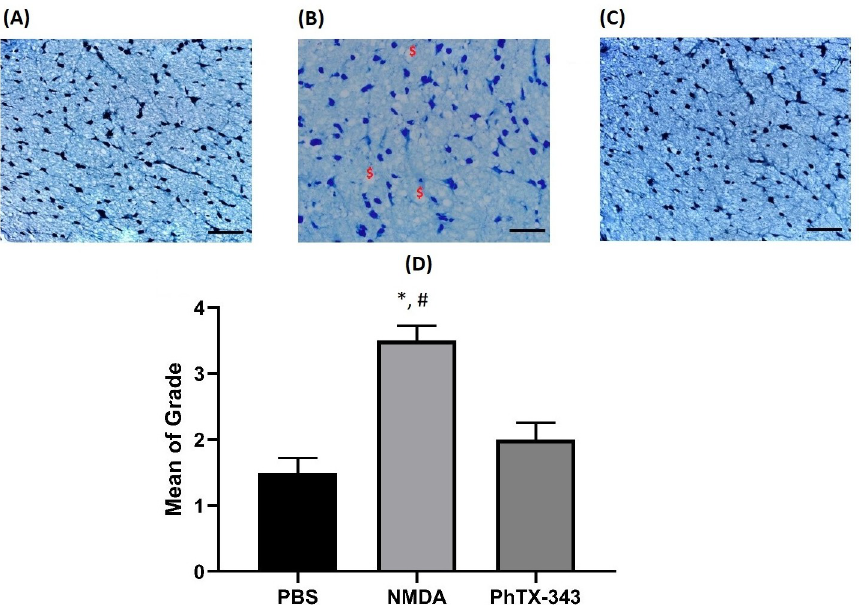
Fig 4. Photomicrographs of optic nerve sections from each group stained with toluidine blue seven days after intravitreal injections. (A) PBS group presenting intact optic nerve, (B) NMDA group showing extensive degeneration and vacuolation of optic nerve, (C) PhTX-343 pre-treatment group followed by NMDA administration after 24 h showing similar distribution of glial cells as in PBS group. The histological analysis was quantified by grading the extent of injury for optic nerve degeneration across the three groups and presented as bar graph (D). ($) marks degenerating fibres with vacuolation. The quantitative data were analyzed using Kruskal-Wallis with Dunn’s multiple comparison test: � p < 0.05 versus PBS; #p < 0.05 versus PhTX-343 (Scale bar 50 μ m).